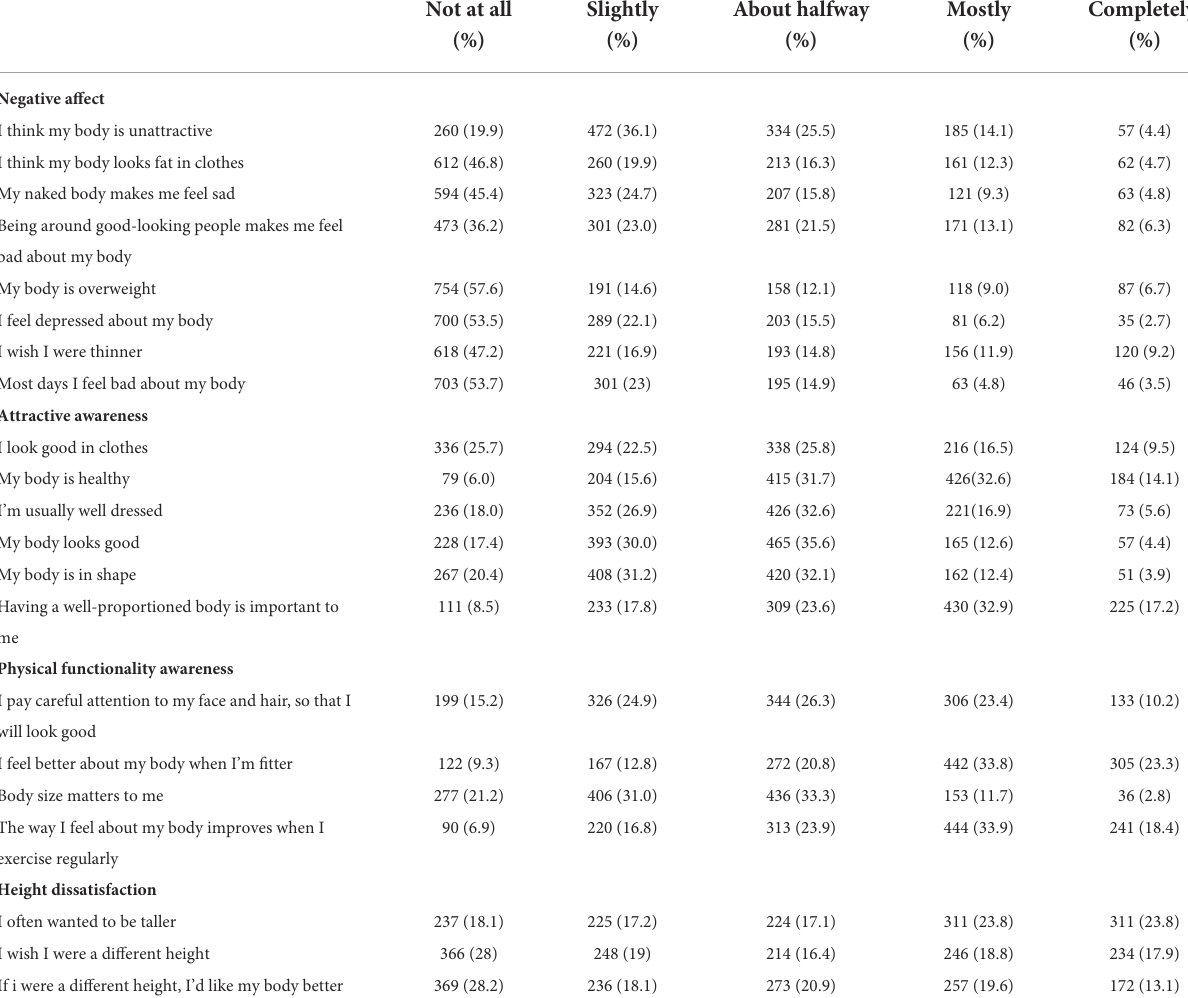
TABLE 3 Body self-image perception of UTAR male undergraduate students according to the BSIQ. Not at all Slightly About halfway Mostly